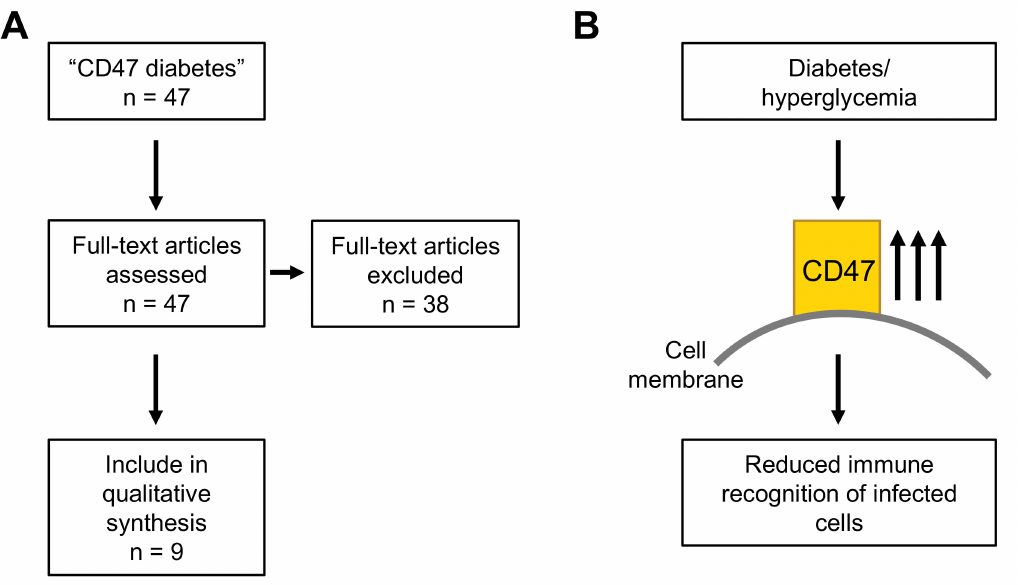
Figure 4. Results of the PubMed (https://pubmed.ncbi.nlm.nih.gov accessed on 17 February 2021) literature search for “CD47 diabetes” ( A ). ( B ) Overview figure of the data derived from the literature search. Hyperglycemia- and diabetes- induced increased CD47 levels may contribute to the immune escape of SARS-CoV-2-infected cells.